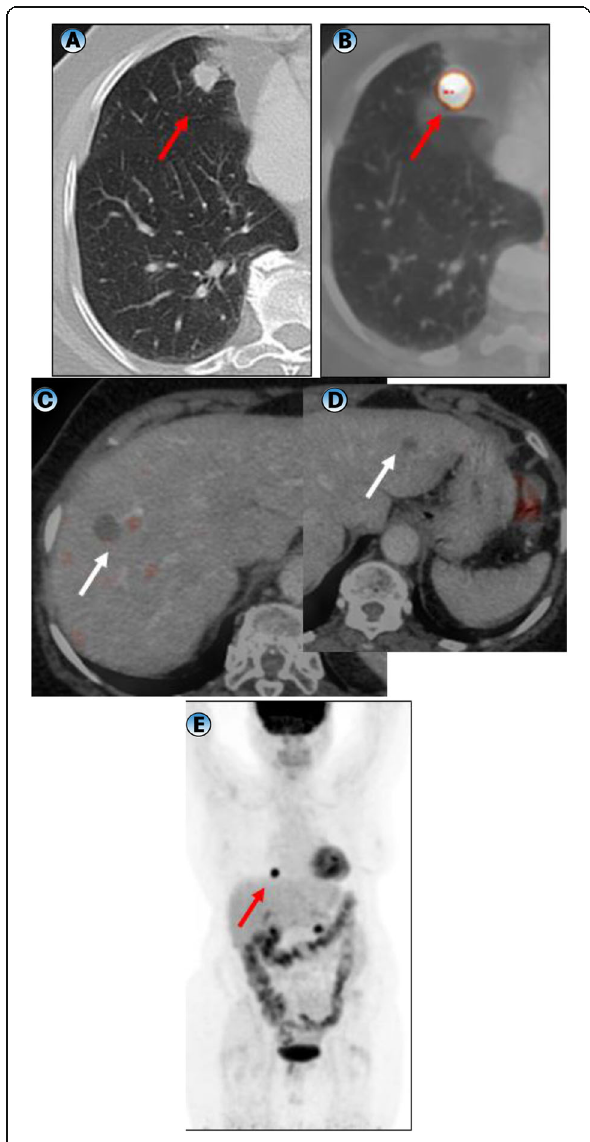
Table 1 Distribution of the studied group as regard general